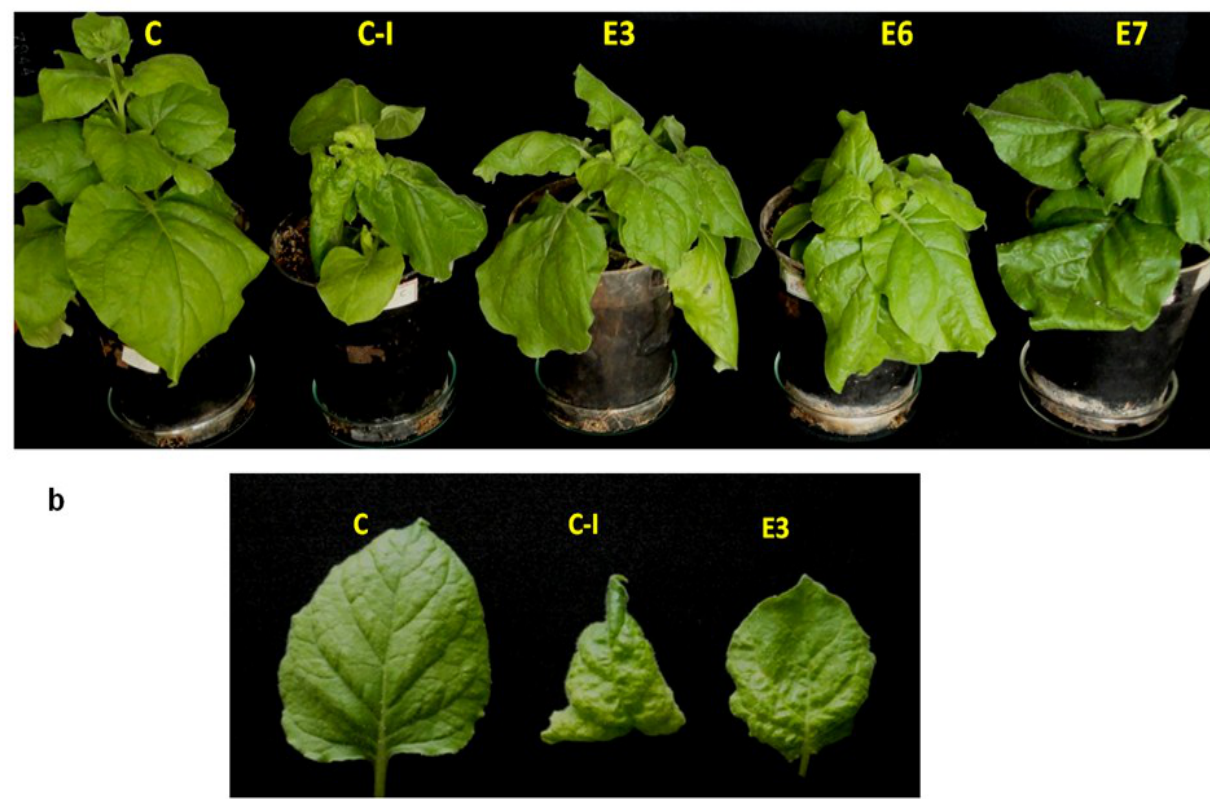
Figure 5. ( a ) Viral symptoms in the virE2 transgenic Nicotiana benthamiana plants (E3, E6, E7) agroinoculated with the partial dimers of Sri Lankan cassava mosaic virus (SLCMV)-[Attur2] DNA A and DNA B. C: untransformed, uninfected N. benthamiana plant . C-I: agroinoculated control N. benthamiana plant as the positive control; ( b ) Individual leaves from uninfected control (C), infected control (C-I) and virE2 transformed (E3) N. benthamiana